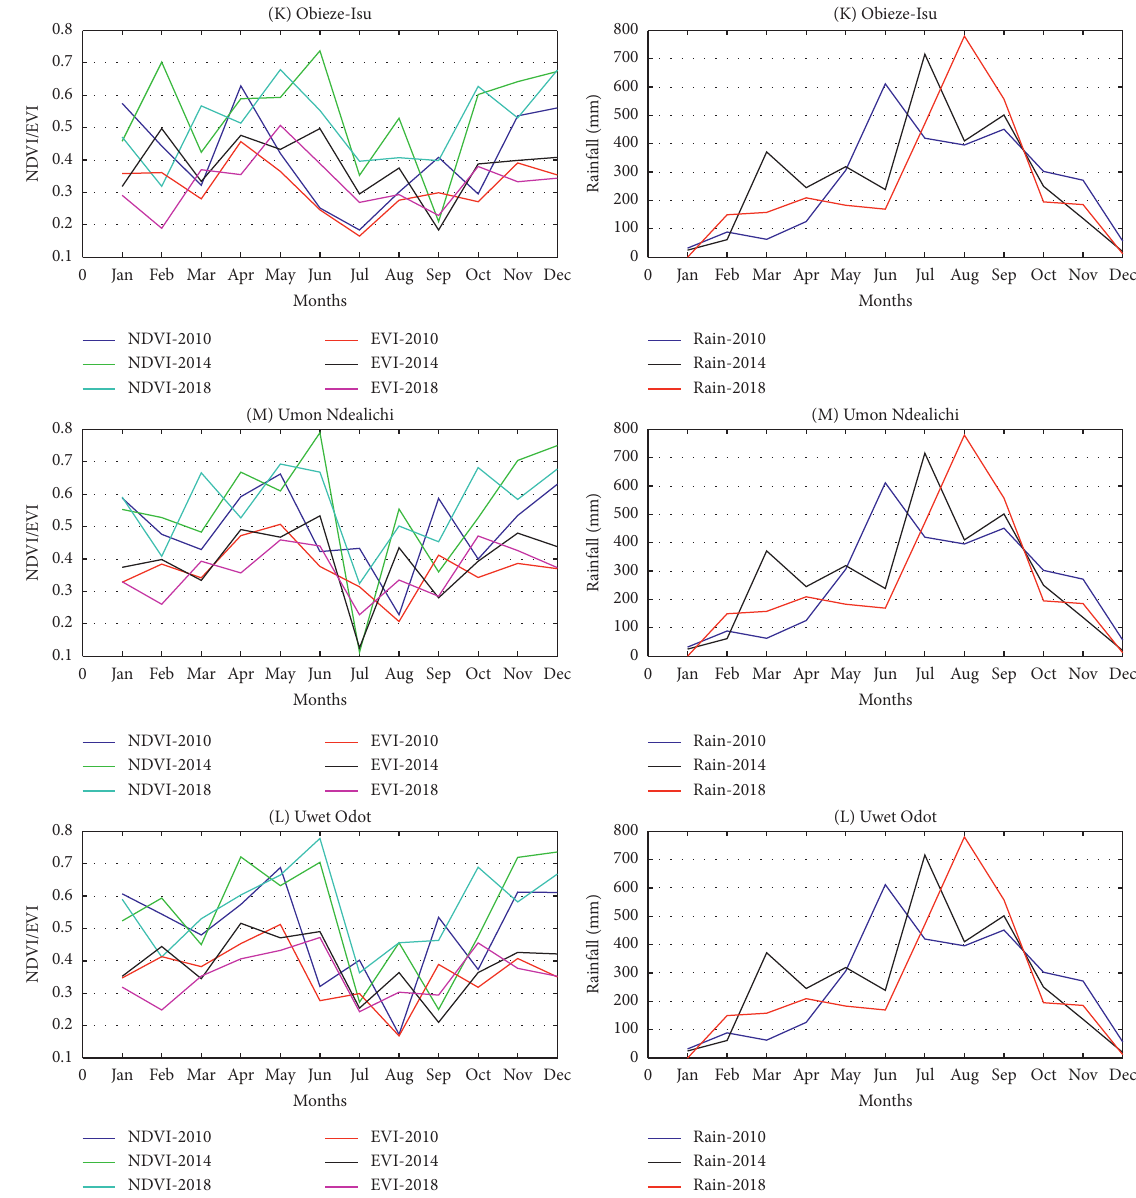
Figure 3: Monthly rainfall, NDVI, and EVI data for each of the three